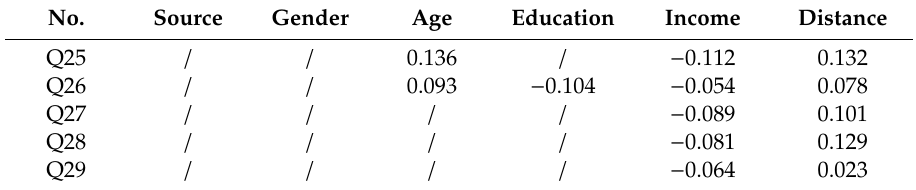
Table 9. B-values of related independent variables of categorical multiple regression